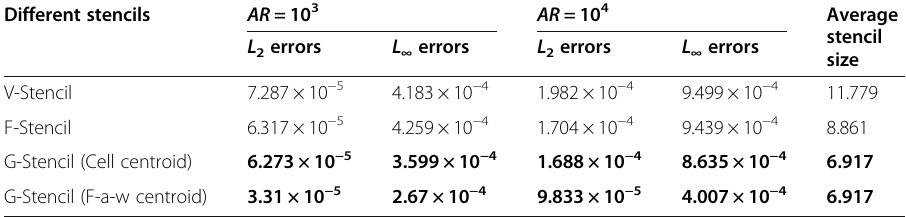
Table 3 Computational errors and average stencil size of different stencils on the finest grid Different stencils